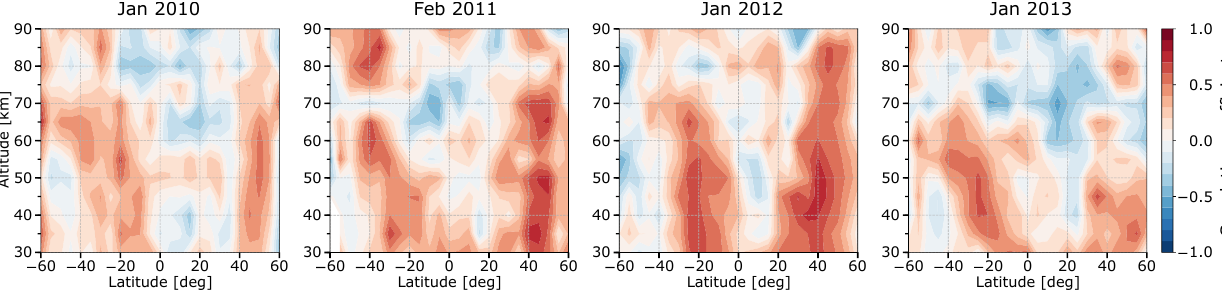
Fig. 6. SABER absolute GWMF at 30, 50, 70, 75, 80, 85, and 90 km are shown from the 1st row to the 7th row, while CHAMP ARDF are shown on a logarithmic scale in the last row. Again, the color scale is individual for each panel in these first two columns. The third column in Fig. 6 shows the correlation coefficients for January (upper panel) and July (lower